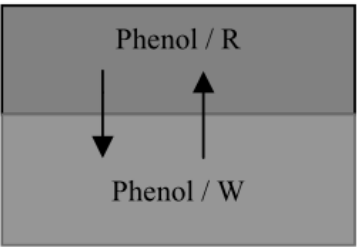
Figure 8. Schematic of liquid-liquid extraction. Adapted from Ref. [45]. Copyright 2003 Elsevier. Jiang et al. [45] investigated the removal of phenol from wastewater containing 6000 mg/L of phenol by the LLE method using octanol (C 8 H 17 OH) as an extractant. Phenolic wastewater and extractant were mixed at 1 atm, ambient temperature, and pH 3.0. Opti-